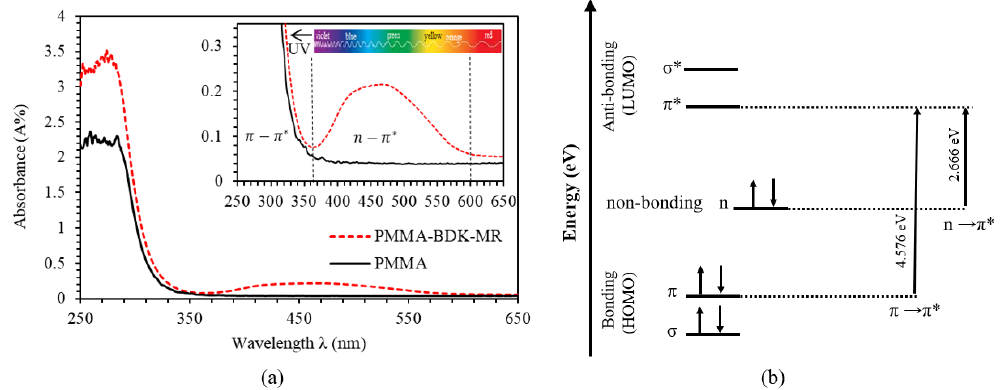
Figure 3. ( a ) Absorbance spectra of PMMA-BDK-MR (Polymethyl Methacrylate-Benzyl Dimethyl Ketal-Methyl Red) polymer composite thin film as a function of wavelength, and ( b ) HOMO and LUMO energy diagram of PMMA-BDK-MR polymer composite thin film concluded from the absorbance spectra shown in Figure 3a. The inset in Figure 3a shows an enlarged absorbance spectra transition.